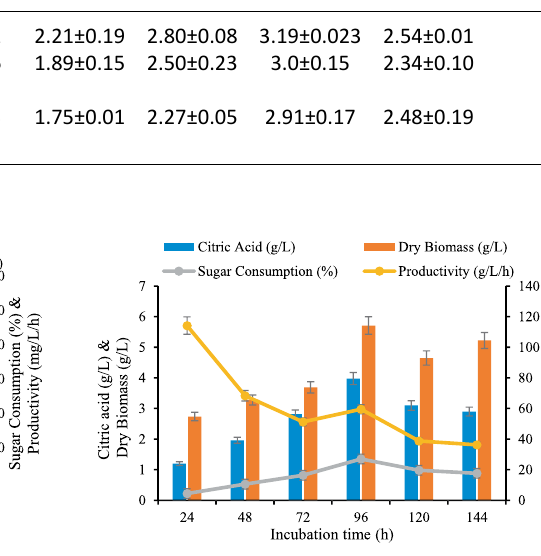
Table. 2. The Effect on enzyme activities (U/mg protein) in A. fumigatus Enzymes